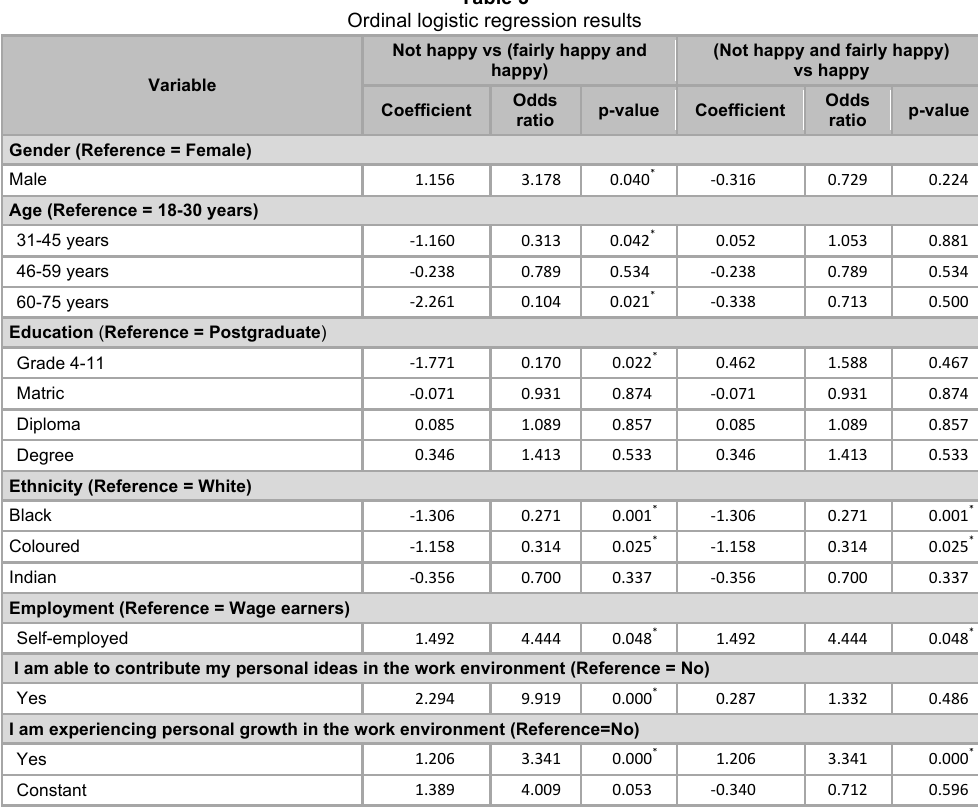
Table 3 Ordinal logistic regression